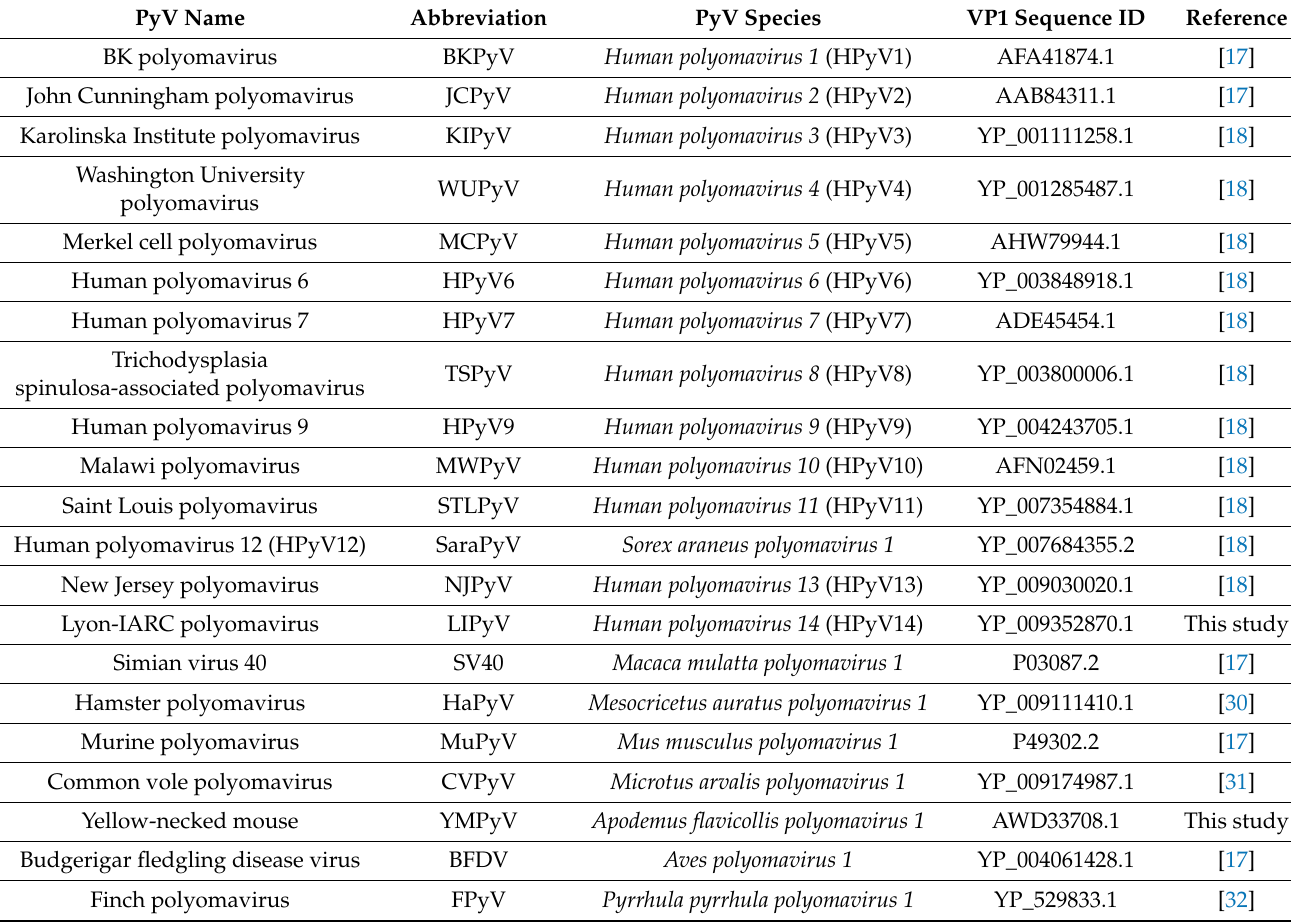
Table 1. The list of PyVs for which VP1-derived VLPs were used in the